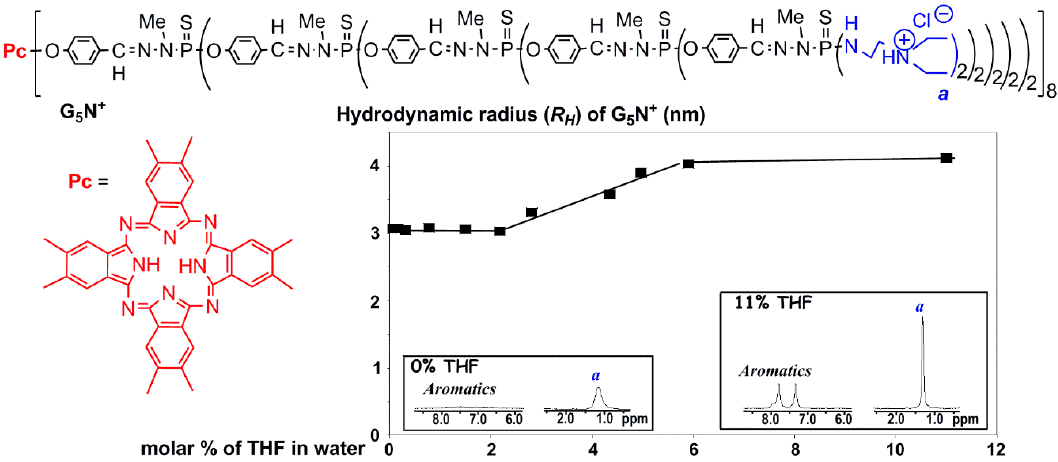
Figure 2. Generation 5 phosphorus dendrimer built from a phthalocyanine core and ended by ammonium groups. 1 H-NMR spectra in water or water/THF mixtures, and variation of the hydrodynamic radius measured by diffusion NMR.